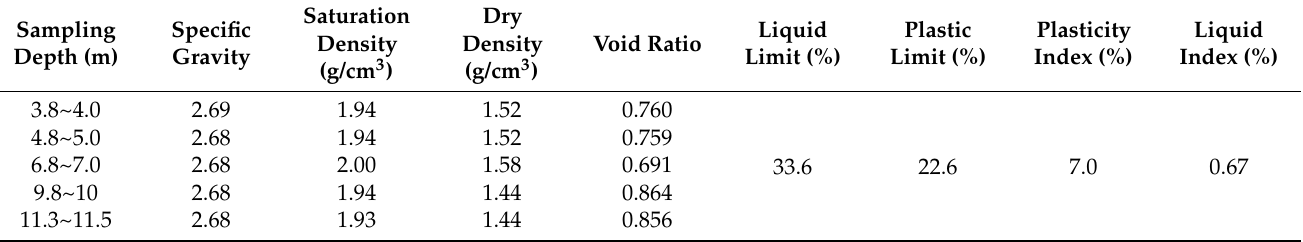
Table 1. Physical indexes of the